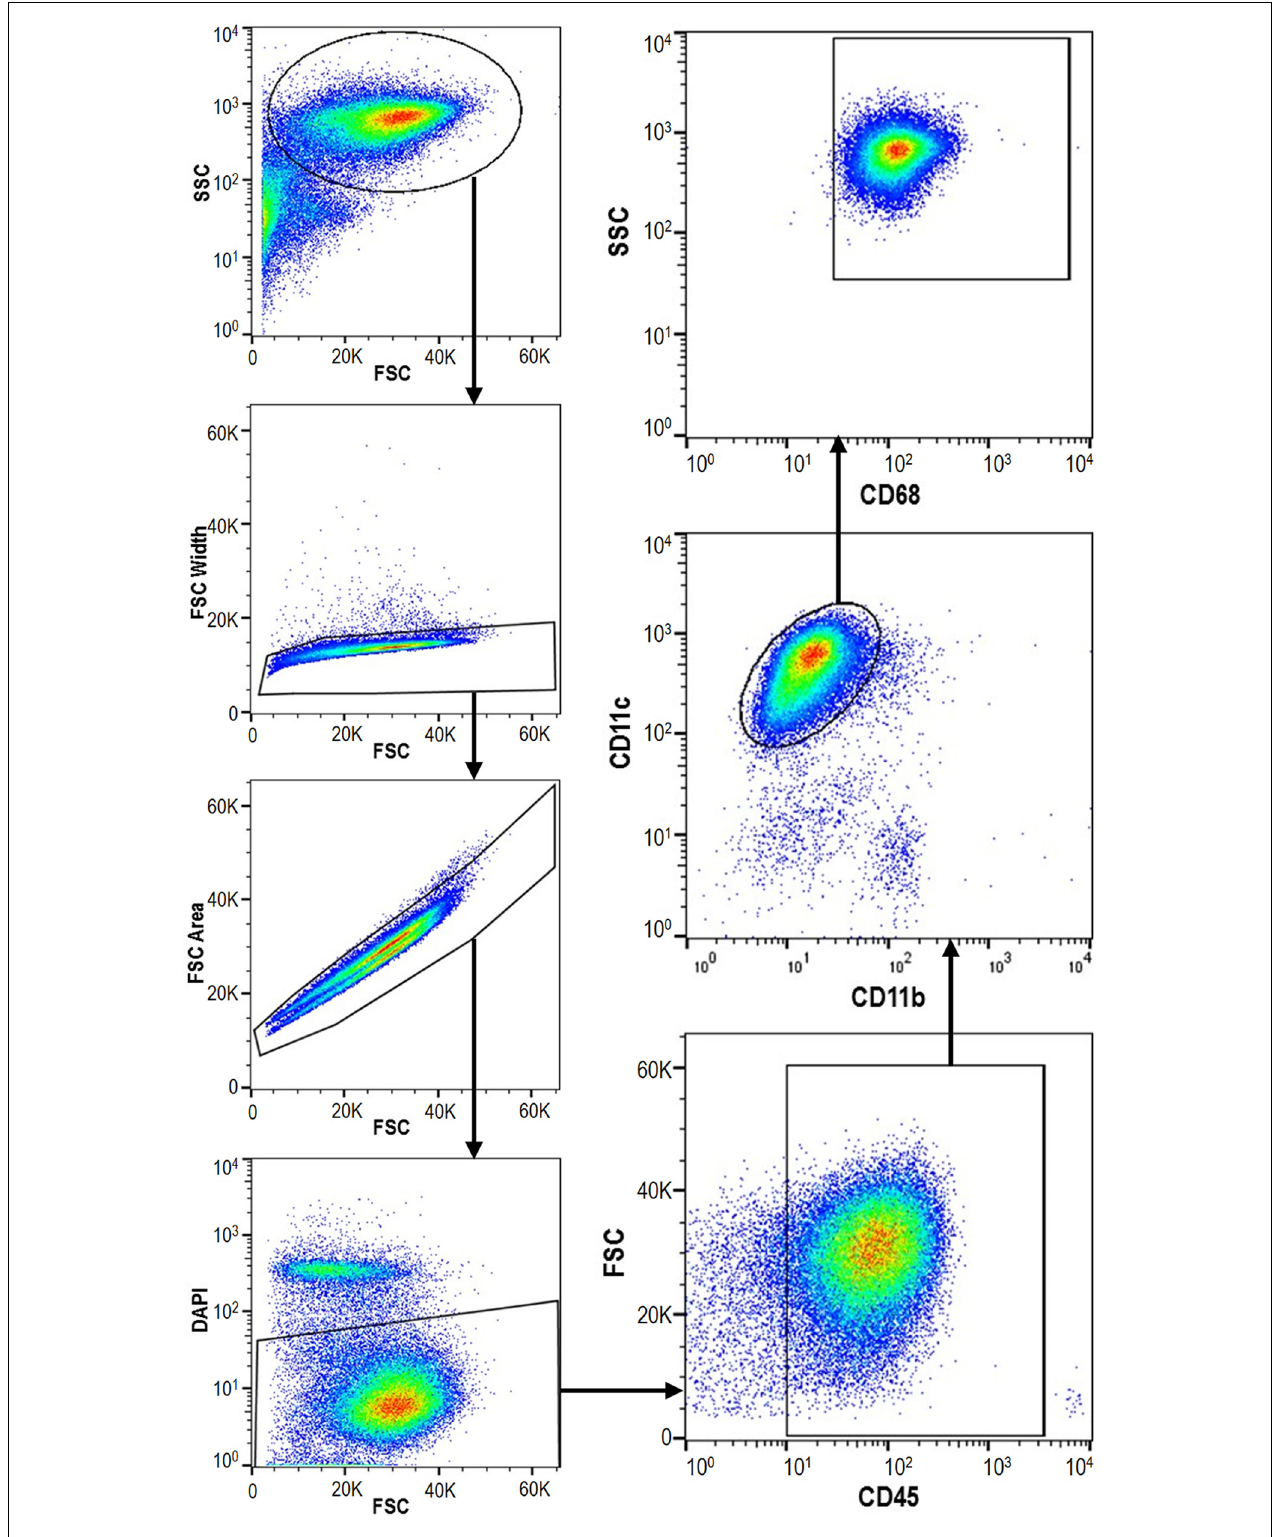
FIGURE 5 | Macrophages represent > 80% of cells isolated by bronchoalveolar lavage (BAL). Cells were collected from lungs of naïve rats ( n = 4) by BAL, labeled with antibodies differentiating macrophages from other leukocytes, and counted by flow cytometry. SSC, side scatter; FSC, forward scatter.